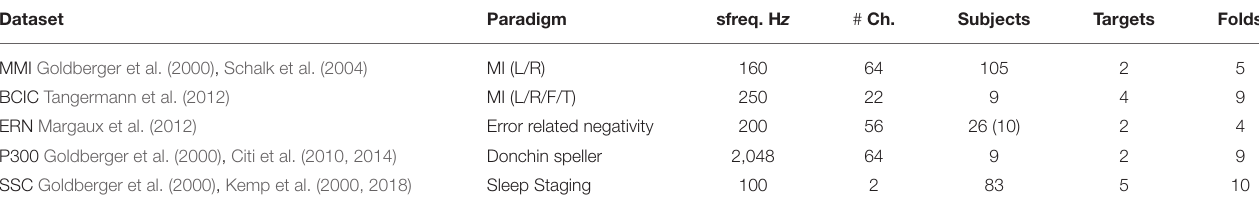
TABLE 1 | Summary of downstream dataset battery and number of cross-validation folds used. Dataset